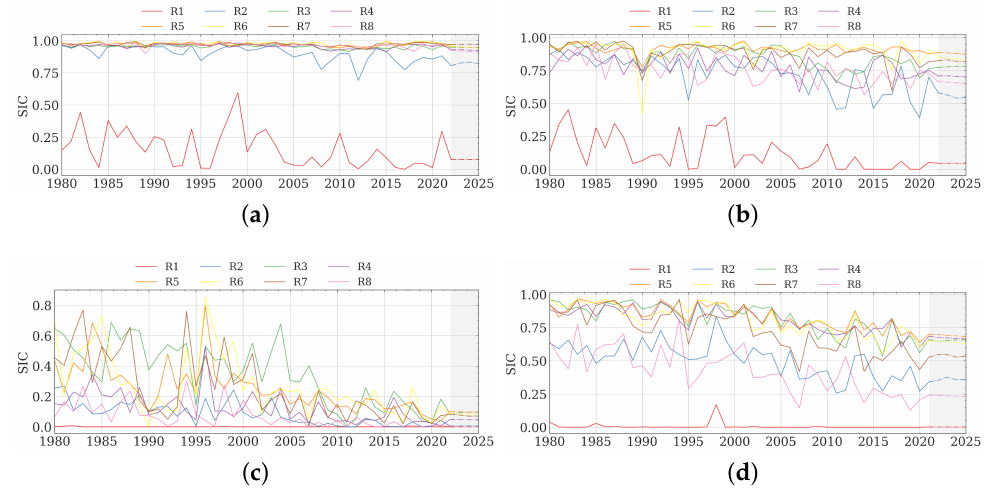
Figure 18. The quarterly means of reanalysis and forecast SICs in all sub-regions. ( a ) January, February, and March (JFM). ( b ) April, May, and June (AMJ). ( c ) July, August, and September (JAS). ( d ) October, November, and December (OND).